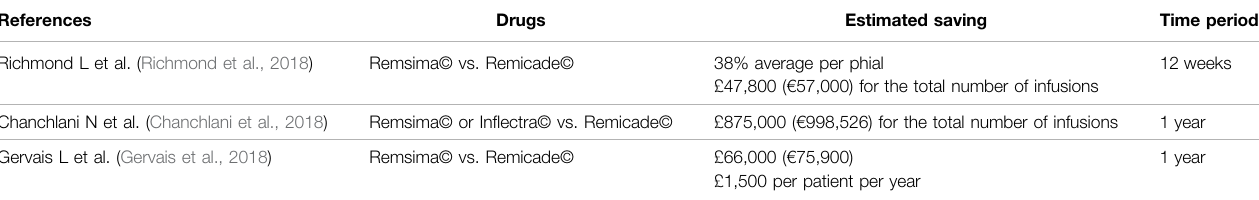
TABLE 4 | Cost saving in comparison to treatment with